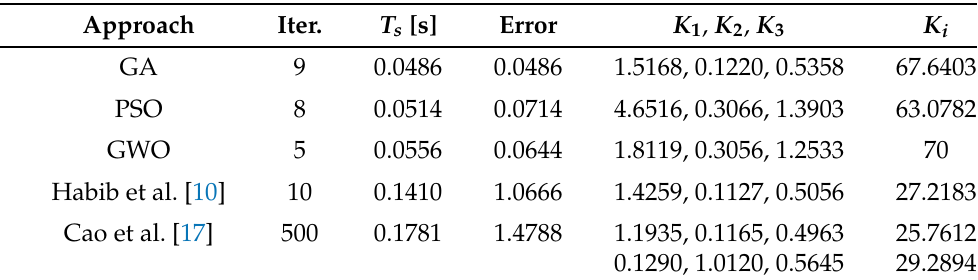
Table 5. Comparative data for the IBC controllers developed with three different metaheuristics and with previous approaches. All controllers were tuned seeking a zero overshoot and calculating the error according to (42) Approach Iter. T s [s] Error K 1 , K 2 , K 3 K